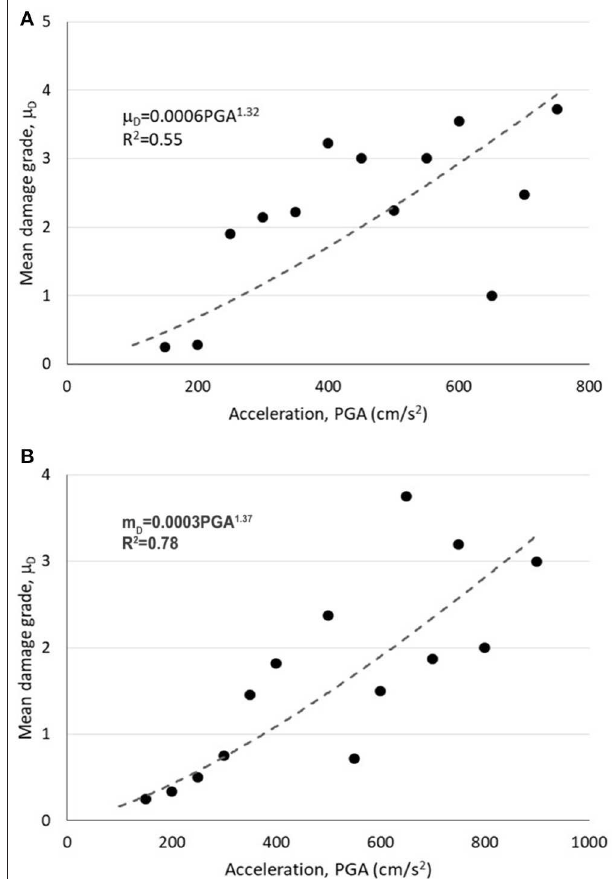
FIGURE 5 | Mean damage grade as a function of peak ground acceleration for (A) URM and (B) CM buildings